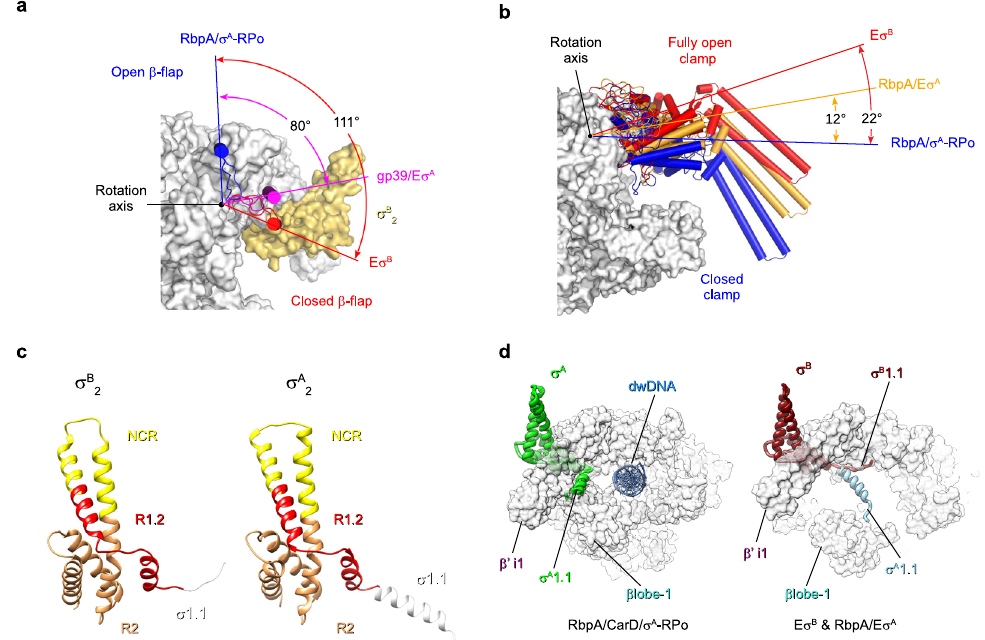
Fig. 3 | Conformational fl exibility of M. tuberculosis RNAP. Motions of the RNAP fl ap ( a ) and clamp ( b ). RNAP is shown as a molecular surface with the core subunits ingrayand σ B inyellow.The fl ap( β fl ap, β subunitaa808 – 832)andclamp( β ‘ subunit aa 1 – 413, 1219 – 1245; β subunit aa 1117 – 1140) domains are shown as cartoons with cylindrical helices.Rotation angles were measured in PyMol as described by 26 . a The β fl ap position in E σ B (in red) relative to its position in RbpA/ σ A -RPo (blue, PDB ID 6C04) and in the T. thermophilus gp39/E σ A complex (pink, PDB ID 3WOD). b The